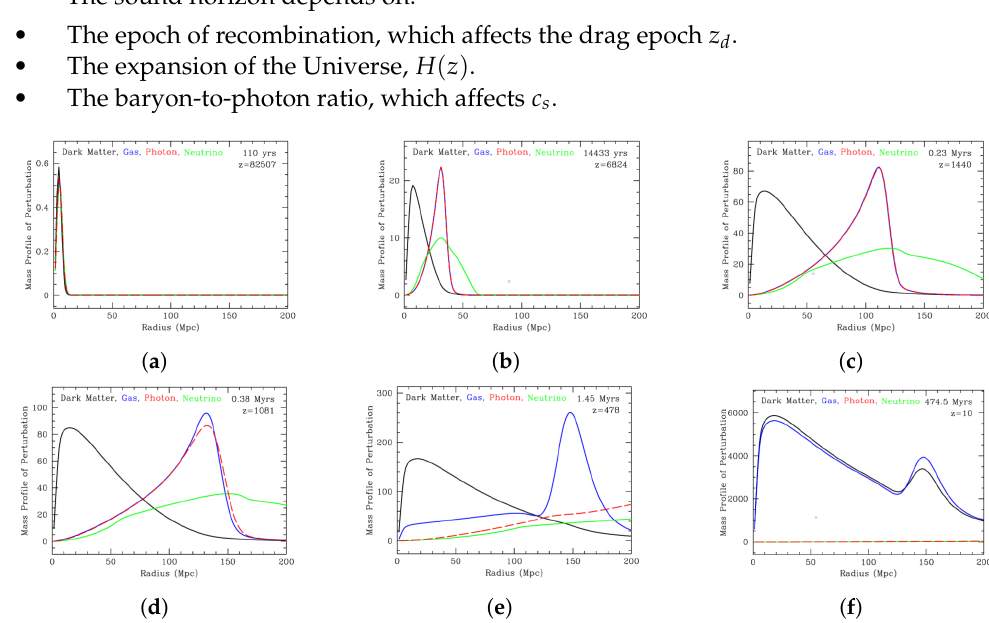
Figure 7. Perturbation evolution: ( a ) Early Universe: initial perturbations. ( b ) Early Universe: neutrinos spread out, acoustic waves form. ( c ) Early Universe: acoustic waves propagate outwards, dark matter perturbation grows. ( d ) Recombination: photons do not scatter efficiently, sound speed drops. ( e ) Photon decoupling: photons spread out, sound wave stalls. ( f ) Before structure formation: dark matter and baryons attract each other and they mix up, with dark matter dominating due to much higher mass. Adapted from: [25], while the original animation can be found here: